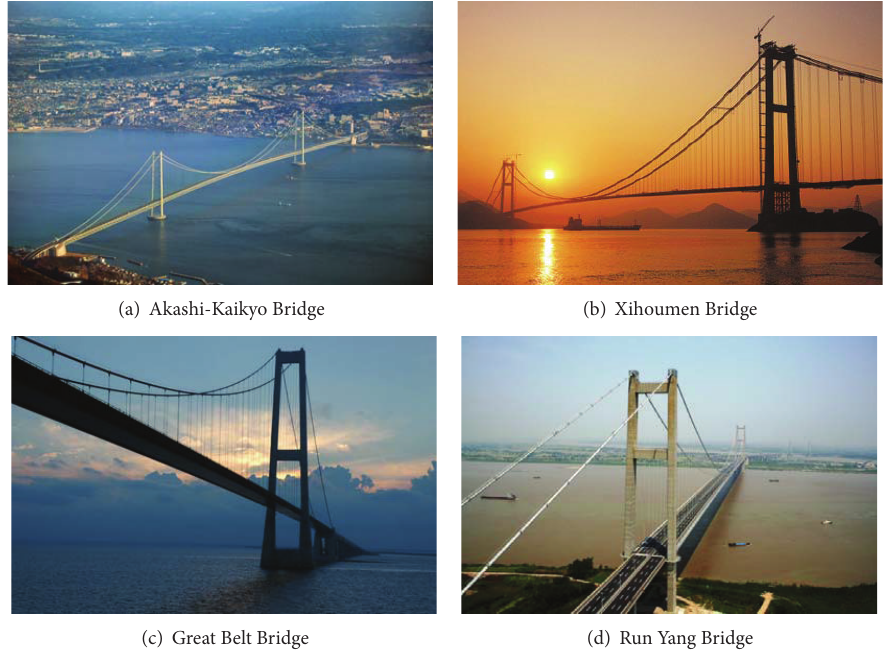
Figure 1: Examples of long-span